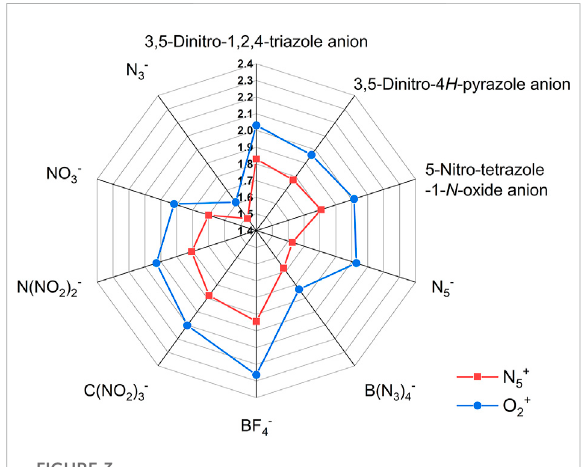
FIGURE 3 TheradarplotofdensityofionicsaltscontainingO 2 + andN 5 +